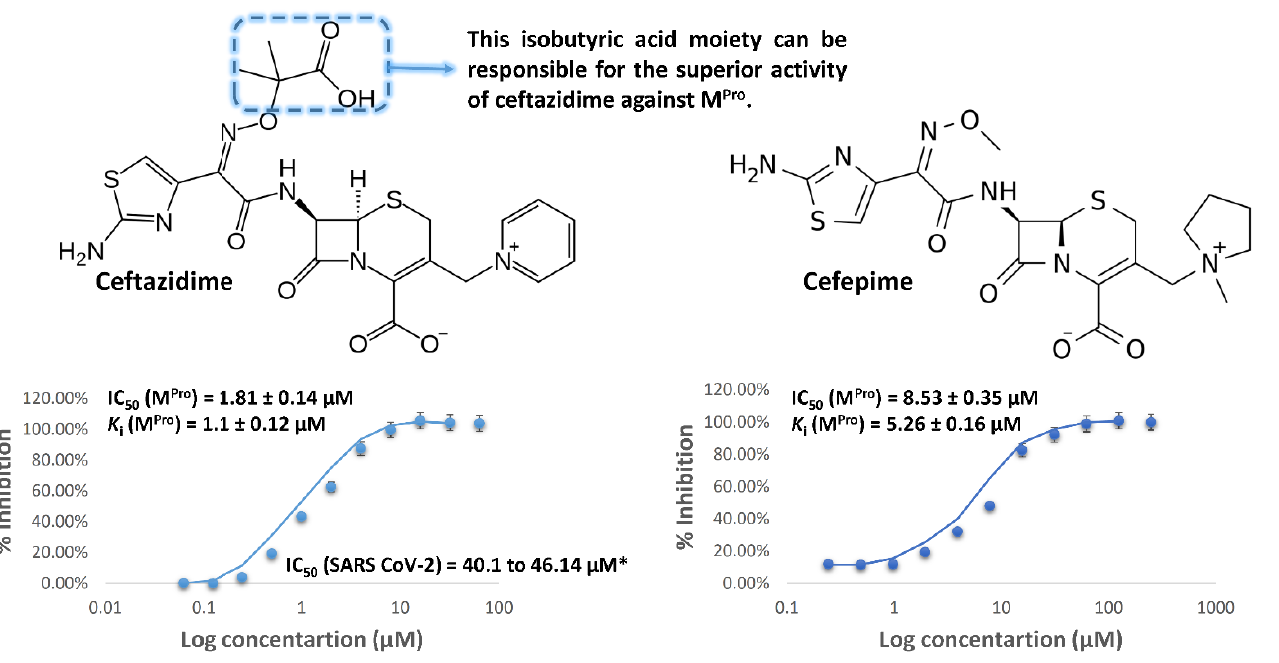
Figure 2. M Pro inhibitory activity of both ceftazidime and cefepime. * Are the previously reported IC 50 values of ceftazidime against SARS CoV-2 [19].